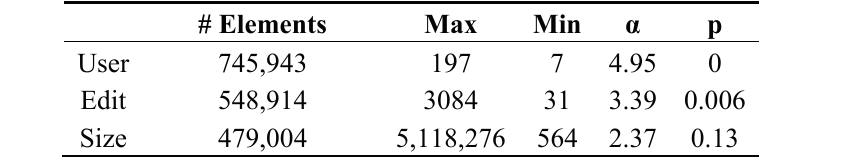
Table 2. Summarized statistics on OpenStreetMap (OSM) elements on top hierarchies in three categories.